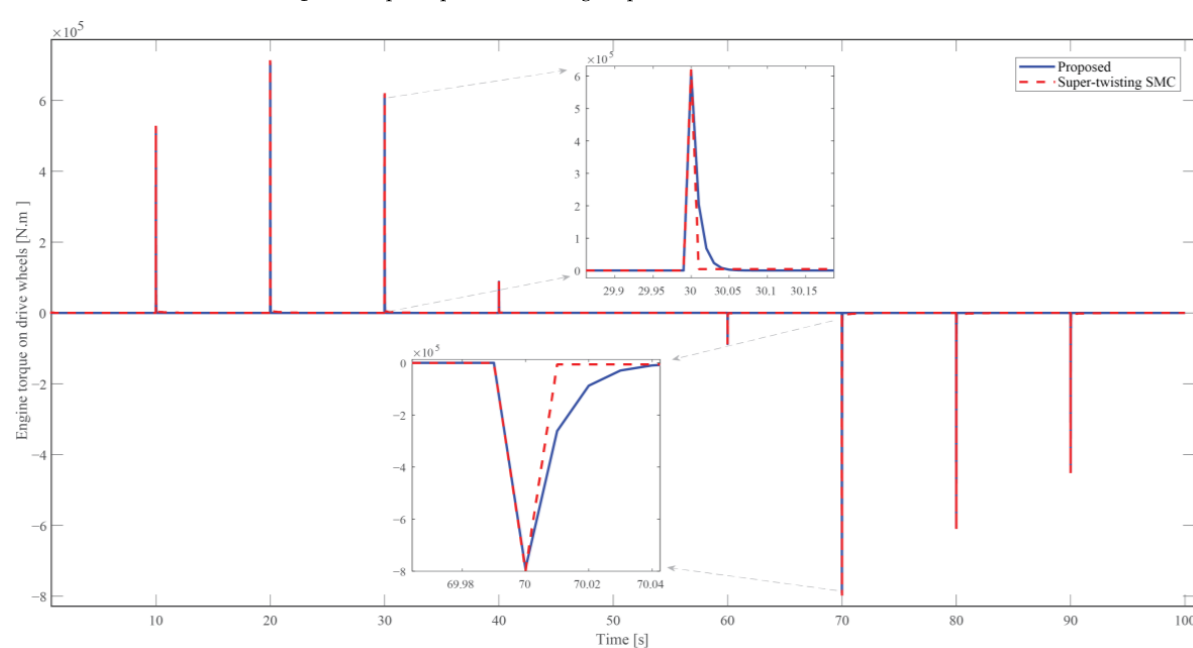
Figure 7. Controller output.